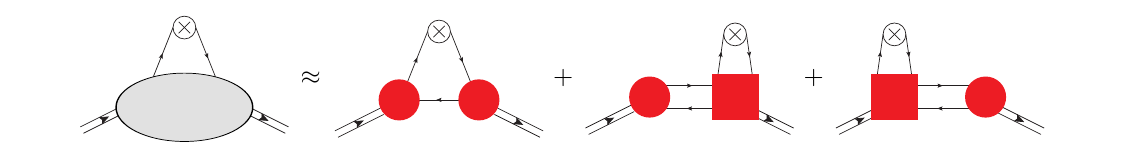
Figure 8. Decomposition of contributions to the local operators when the Bethe–Salpeter amplitude is momentum-dependent. The red circles correspond the standard Bethe–Salpeter amplitudes, while the squares include modifications allowing the insertion of the local operators.